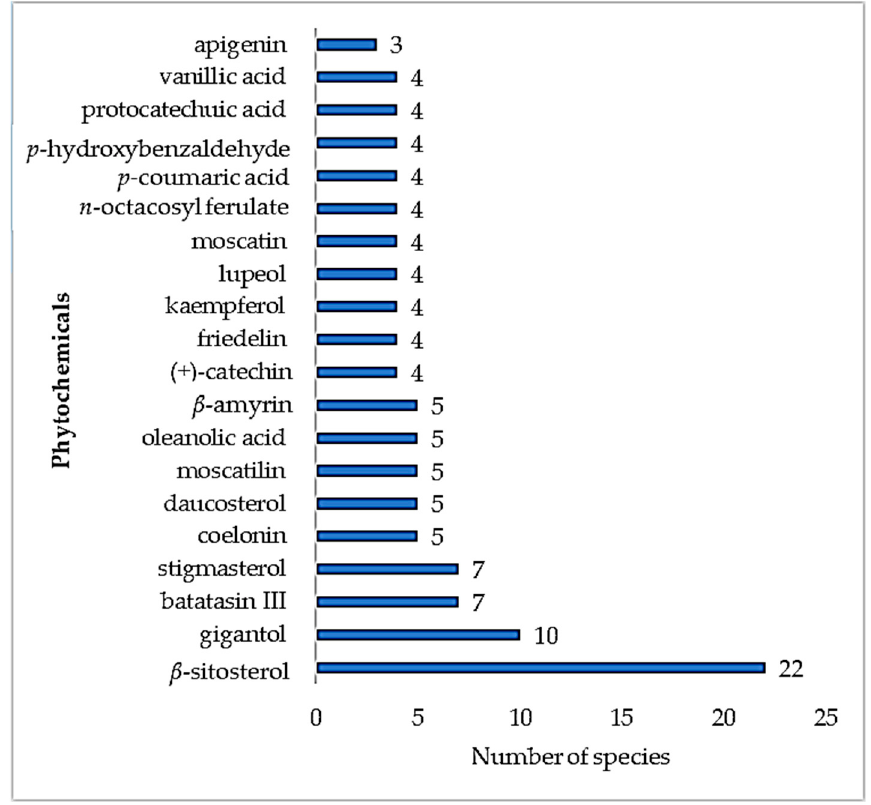
Figure 7. Number of epiphytic medicinal plant species producing the same secondary metabolites.